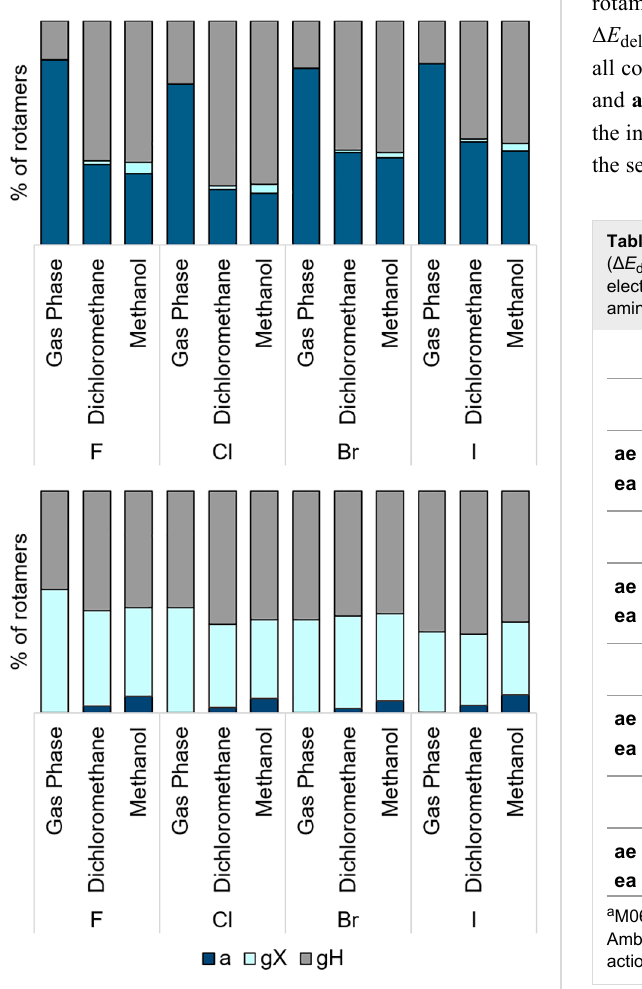
Figure 4: Populations of rotamers a , g X e g H in ae (top) and ea (bottom) conformers of cis -2-halocyclohexylamines in the gas phase, dichloromethane and methanol.